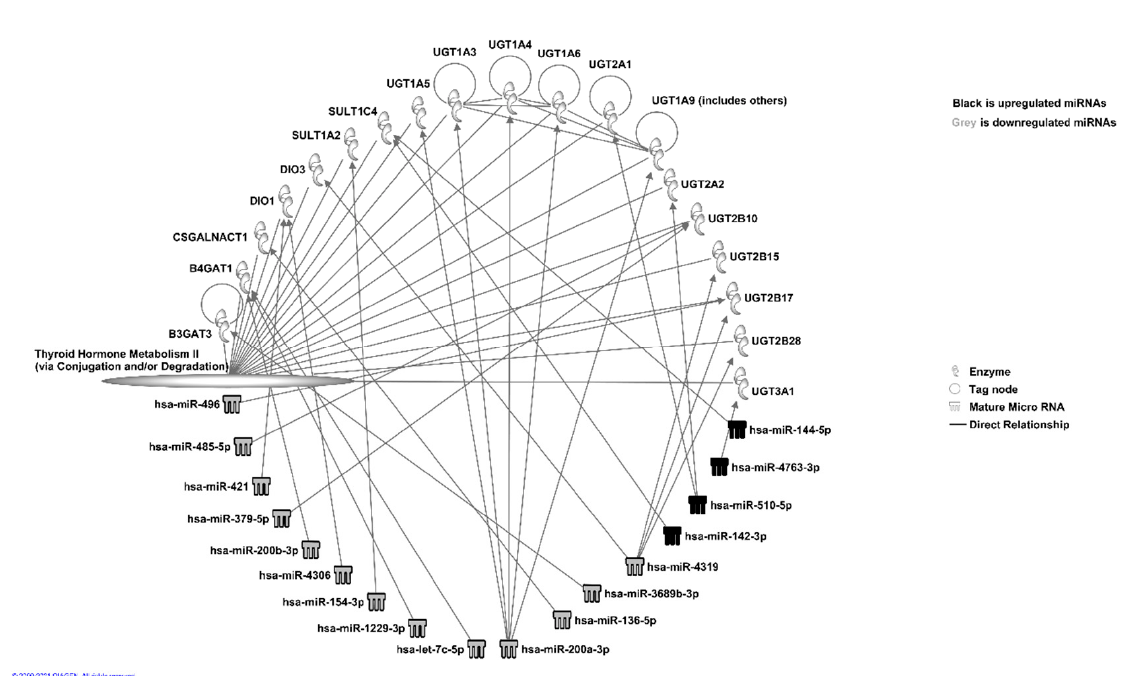
Figure 4. miRNA interaction analysis using IPA (© 2021-2021 QIAGEN) of miRNA Target Filtering program that uses results from TargetScan to identify the high-confidence putative miRNA targets. Figure shows miRNAs and their targets involved in thyroid hormone metabolic pathway II.